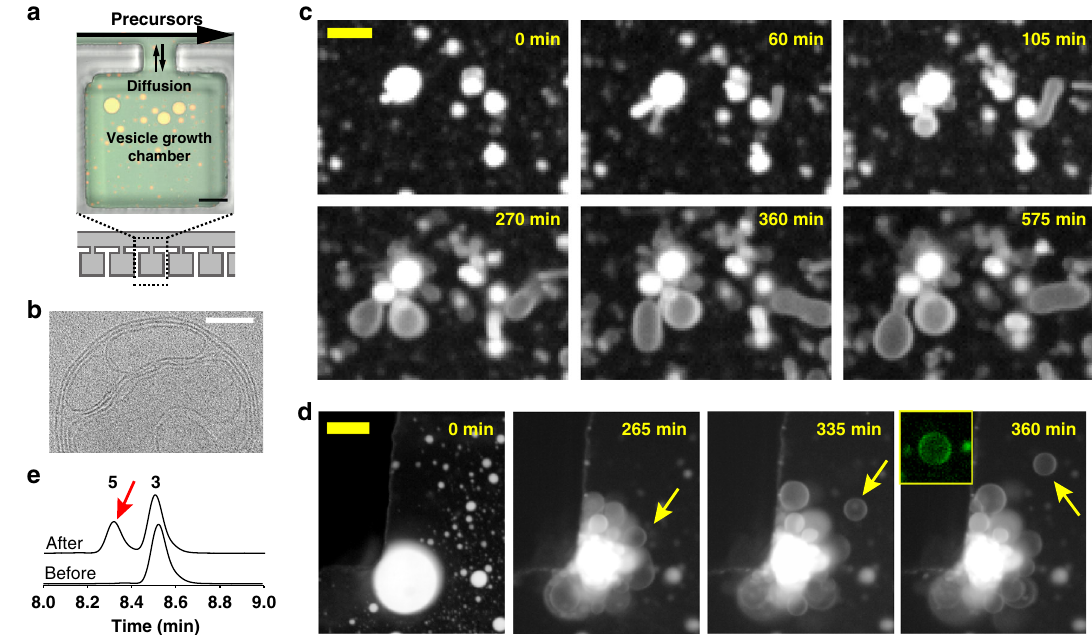
Fig. 3 Membrane growth and division in a micro fl uidic device. a Schematic representation of a micro fl uidic chip utilized to entrap phospholipid 3 giant vesicles encapsulating Alexa Fluor ® 488-labeled FadD10 and ATP. Reactive precursors (dodecanoic acid, lysolipid 4 , ATP, and MgCl 2 ) were continuously fl owed with simultaneous spinning disk confocal microscopy. Scale bar: 50 µ m. b Cryo-transmission electron microscopy (cryo-TEM) image of a large multilamellar vesicle prepared as per the vesicles used for the micro fl uidics experiments. Note the presence of abundant internal membranes. Scale bar: 100 nm. c Fluorescence microscopy images (Texas Red ® channel) corresponding to vesicle growth over time. Scale bar: 10 µ m. See Supplementary Movie 3. d Fluorescence microscopy images (Texas Red ® channel) corresponding to vesicle division. The yellow arrows indicate the formation and departure of a daughter vesicle. Scale bar: 20 µ m. Inset depicts the daughter vesicle in the Alexa Fluor ® 488 channel. In c and d , the images are scaled logarithmically to enhance visibility of internal membranous structures. See Supplementary Movie 4. e HPLC-MS experiment demonstrating formation of phospholipid 5 (indicated in red arrow) upon addition of lysolipid 4 and other precursors to phospholipid 3 giant vesicles encapsulating FadD10